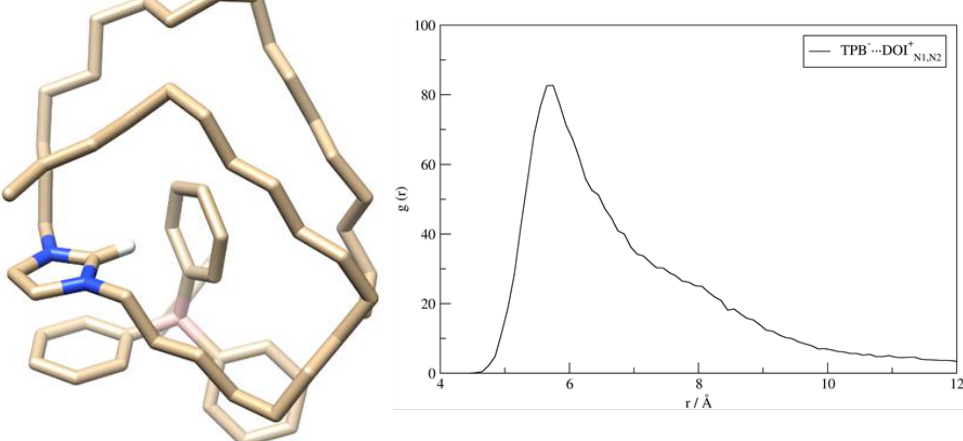
Figure 1. Representative structure of the DODI – TPB complex in the aqueous solution (left; hydro- gen atoms omitted for the clarity) as elucidated from the 300 ns molecular dynamics simulation, and the matching RDF graph considering N(DODI + )∙∙∙B(TPB – ) distances with the peak value located at 5.7 Å (right).